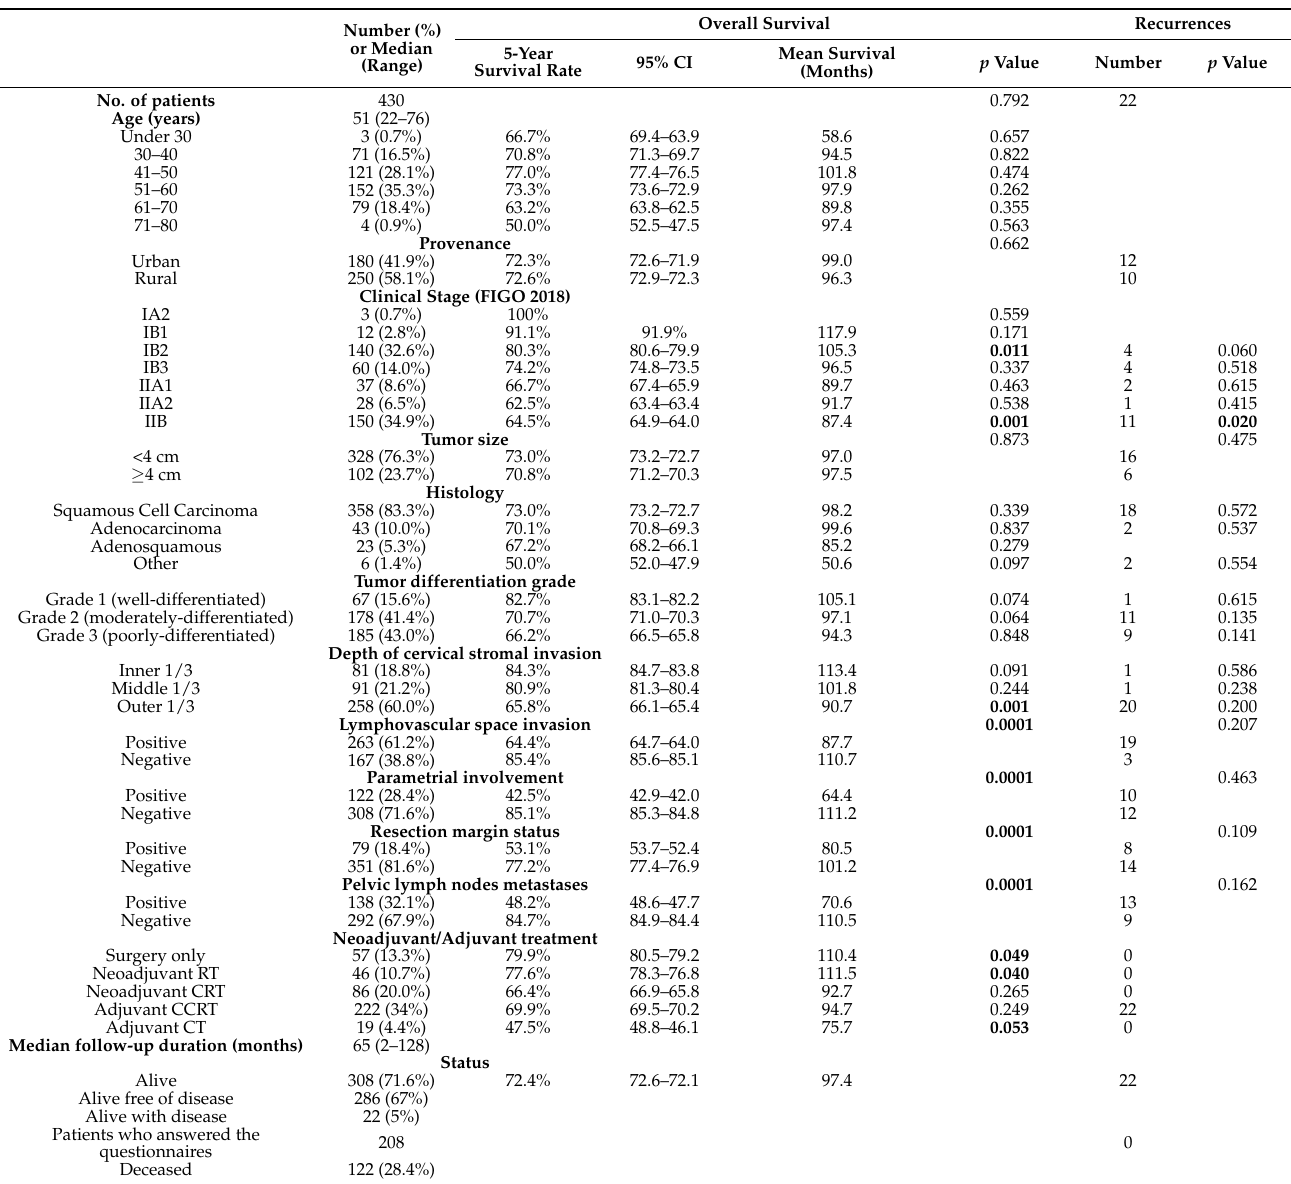
Table 1. The demographic, clinical aspects, and the univariate overall survival analysis of the 430 patients included in the